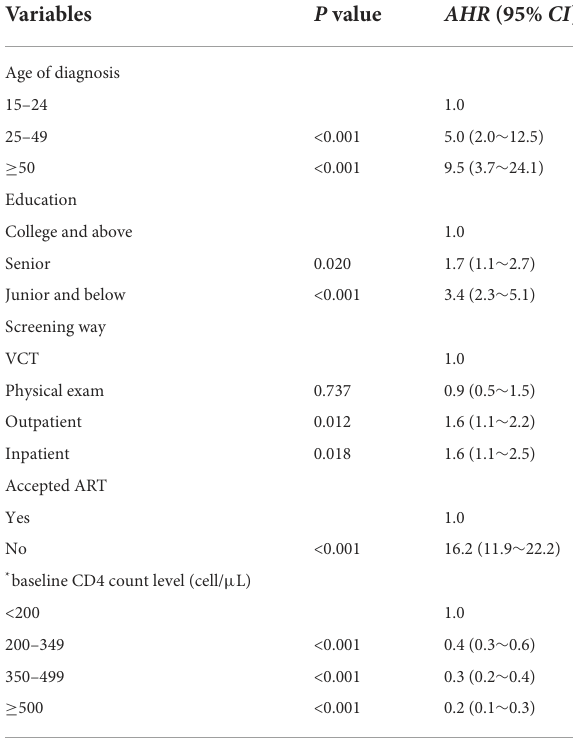
= 0.2 for CD4 ≥ 500 cell/ µ L). In addition, higher mortality TABLE 3 Multivariate analysis of the factors associated with mortality among PLHIV in